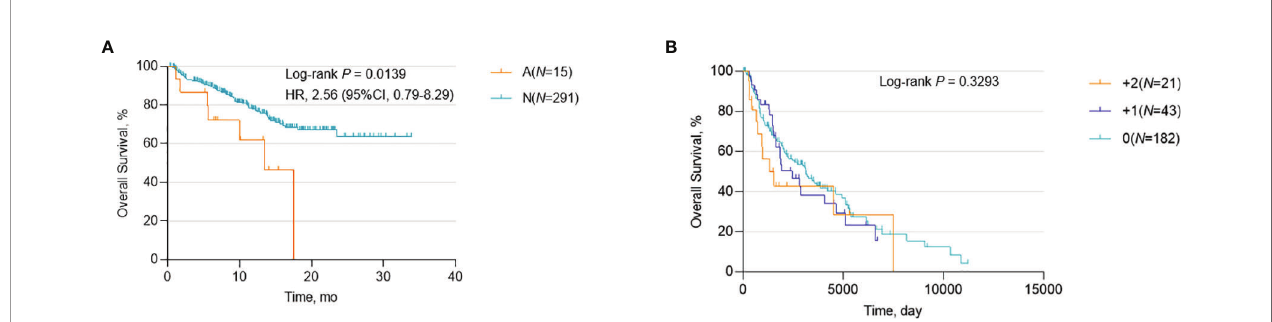
FIGURE 2 | Association between survival and CCND1 ampli fi cation in patients with melanoma. Kaplan-Meier survival analysis of melanoma patients, regardless of ICI use, calculated using data from (A) the MSKCC database ( n =306) and (B) the TCGA database ( n =246). ICI, immune checkpoint inhibitor; MSKCC, the